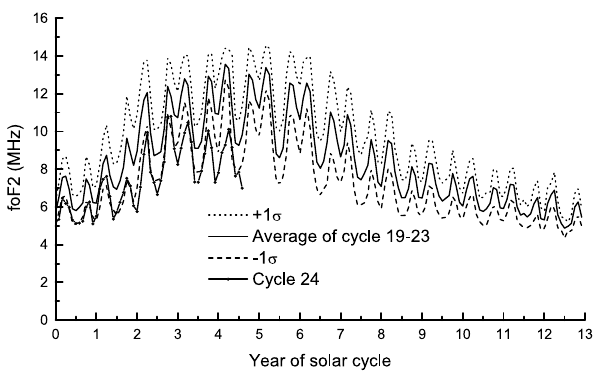
Figure 2. Similar to Fig. 1, but displayed are the monthly mean fo F2 of both SC24 and SC19–23. The standard deviations ( ± 1 σ ) about the mean fo F2 of SC19–23 are shown in dotted and dashed lines as